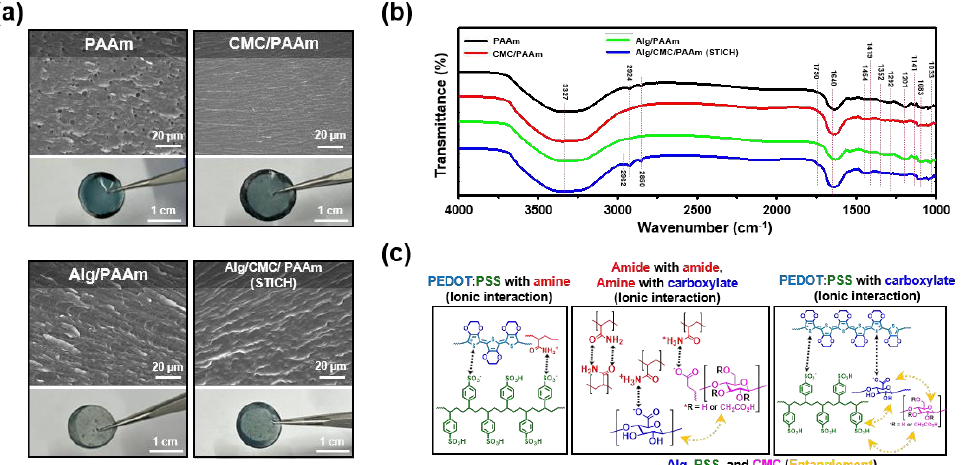
Figure 2. Physicochemical characterization of the Alg, CMC, and PAAm-based conductive hydrogels. ( a ) Cross-sectional SEM images (top, scale bar = 20 µ m) and photographs (bottom, scale bar = 1 cm) of each Alg, CMC, and PAAm-based conductive hydrogel. ( b ) FT-IR spectra of the Alg, CMC, and PAAm − based conductive hydrogels. ( c ) Mechanism of the ionic interactions between the PEDOT:PSS/PAAm, PAAm/polyanions (Alg or CMC), and PEDOT:PSS/Alg. (“PAAm”, black; “Alg/PAAm”, green; “CMC/PAAm”, red; and “Alg/CMC/PAAm”, the STICH, blue). The FT-IR peaks provided clear evidence for the aforementioned hypothesis (Figure